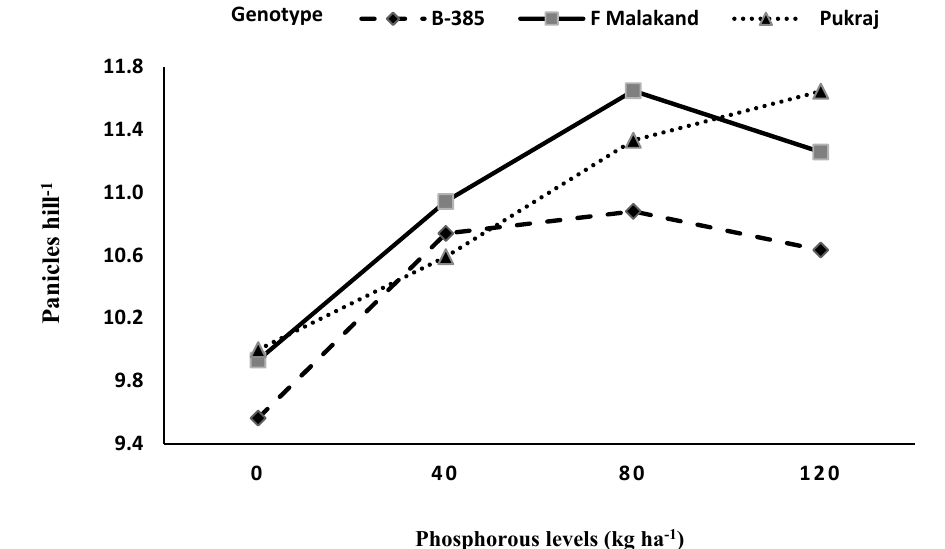
Means of the same category followed by di ff erent letters are significantly di ff erent at 5% level of probability using LSD test. ns stands for non-significant, while *, ** and *** stands for significant at 5, 1, and 0.1% level of probability, respectively.